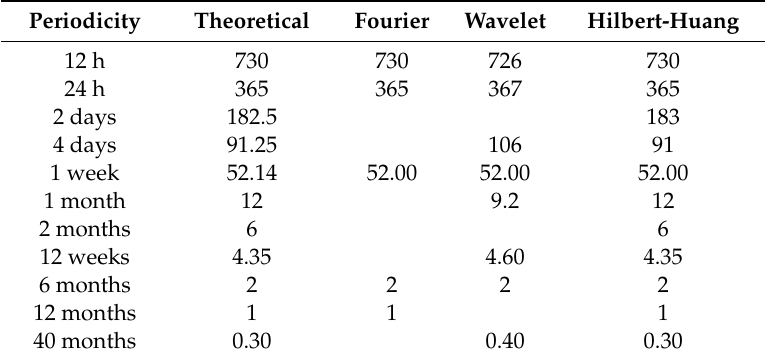
Table 2. Comparison of spectral analysis